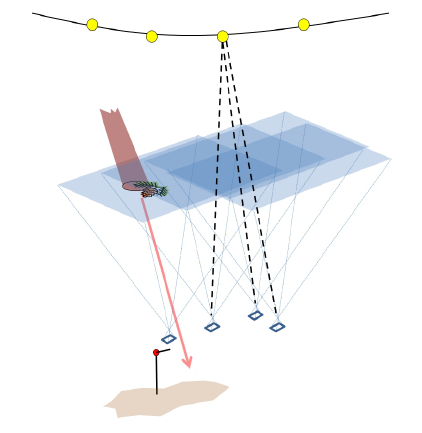
Figure 1. An illustration of the preferred pulse-camera geomet- ry. The leftmost camera is adjacent to the pulse path with its optical axis pointed towards the zenith. The camera was attach- ed to a monopod with a ball joint mount. The dashed lines dep- ict ray intersection to tie points, which were natural or artific- ial, as depicted